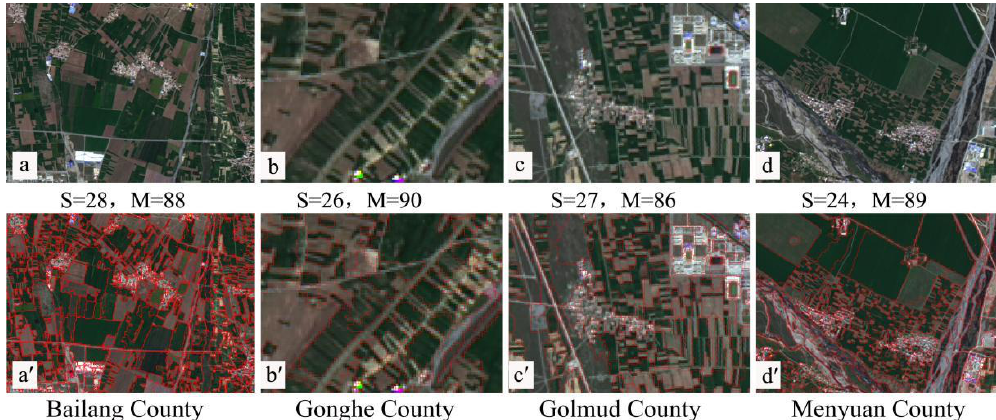
Figure 3. Segmentation results under different segmentation scales. ( a – d ) show the image before segmentation, and ( a′ – d′ ) are after segmentation.